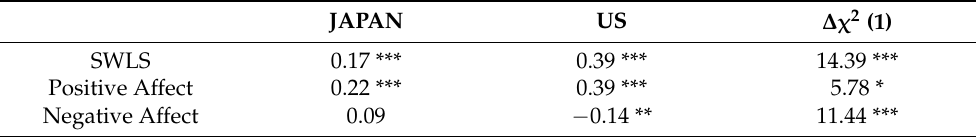
Table 8. National differences in correlations between Compensatory Secondary Control and